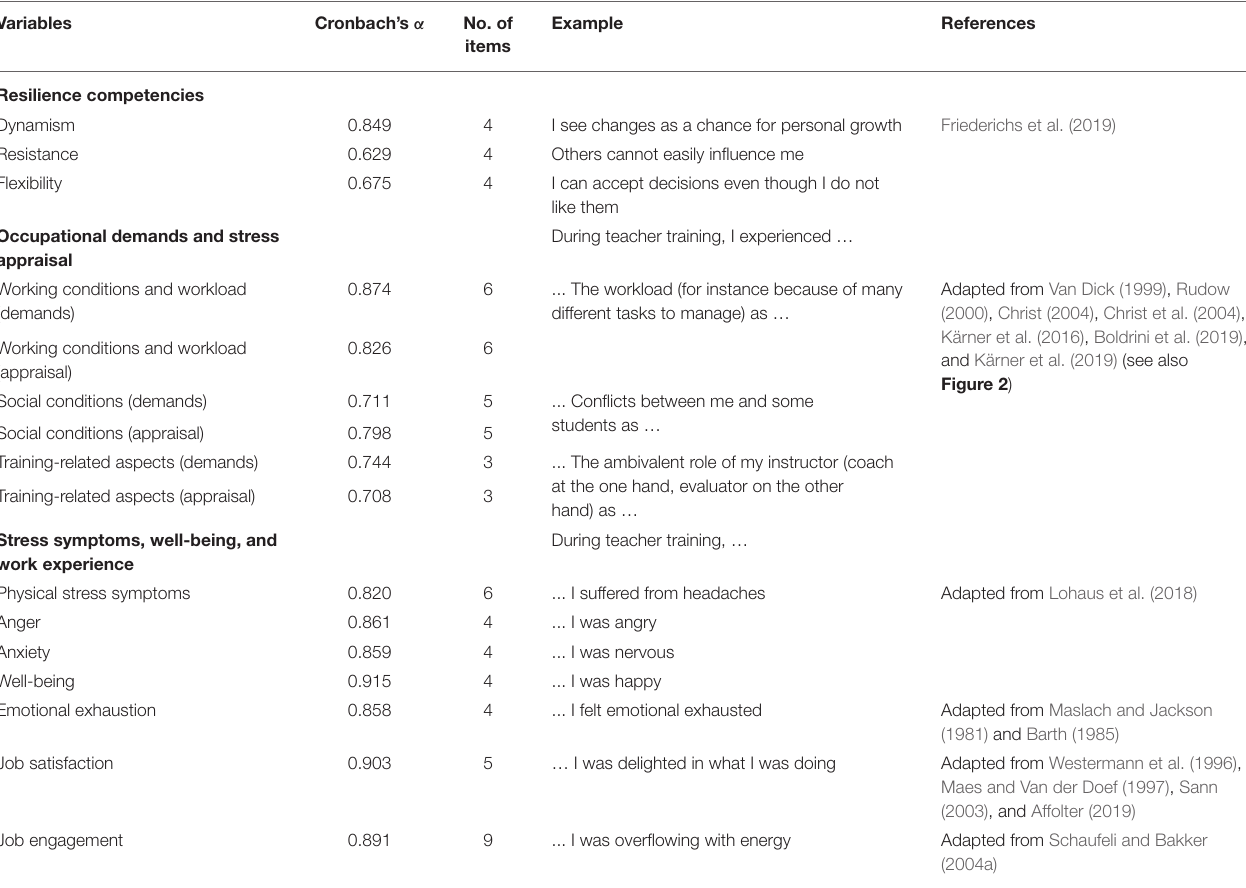
TABLE 1 | Measures and